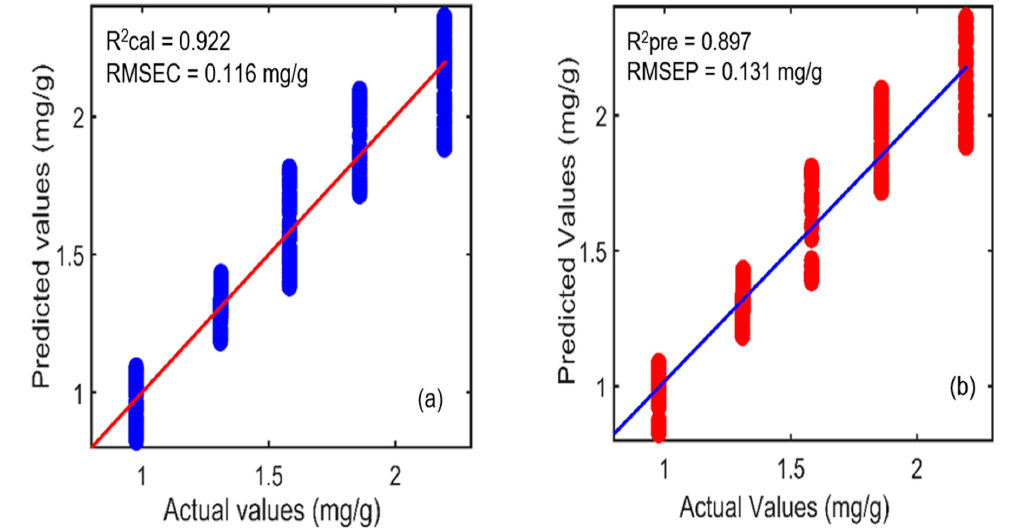
Figure 13. Actual and predicted concentration values for the phenolic compounds in A. thaliana leaf powder samples using the hybrid linear analysis (HLA/GO) model for ( a ) calibration and ( b ) prediction datasets. Here, RMSEC and RMSEP represent the root-mean-square error for calibration and prediction, respectively.